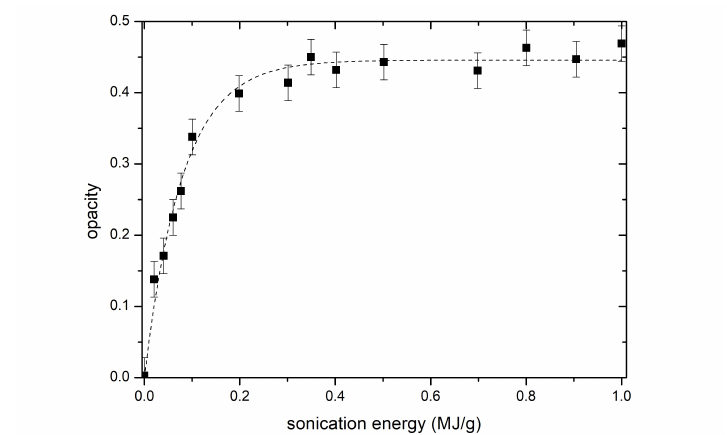
Figure 1. Opacity of 300 times diluted CNT colloid supernatant as a function of sonication energy per CNT mass with fitted logistic function.